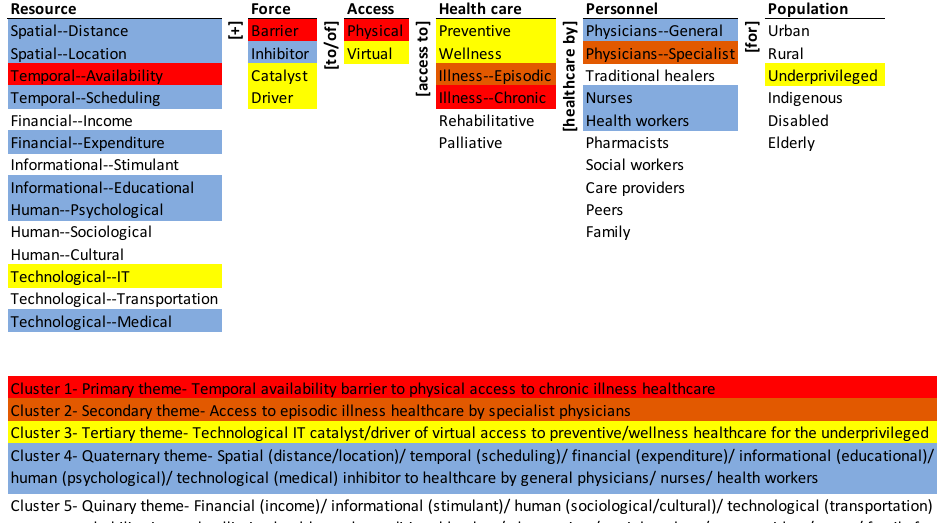
Figure 3. Monad map of research on access to healthcare during COVID-19.